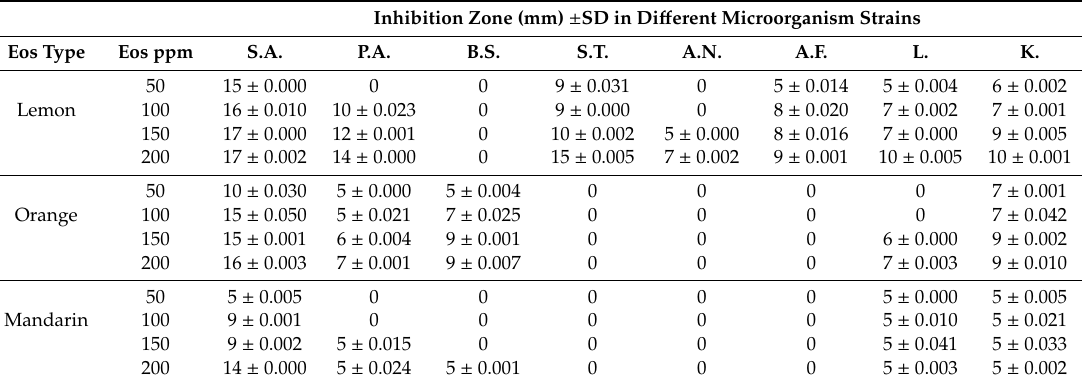
Table 2. The antimicrobial capacity of the essential oils on the di ff erent microbial